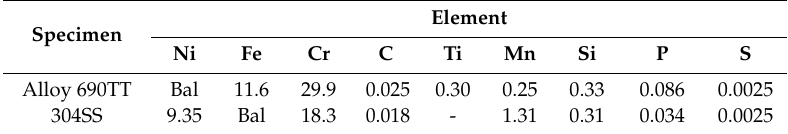
Table 1. Chemical composition of alloy 690TT and 304SS (wt.%).